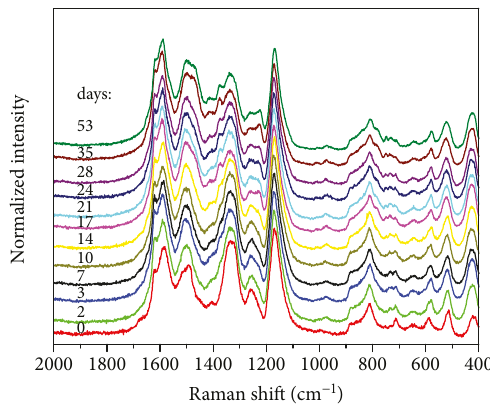
Figure 5: Raman spectra of the PANI-S fi lm on gold obtained with the 633nm excitation line at a marked time after preparation. The samples were stored at room temperature in air.